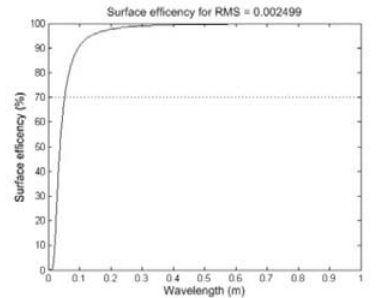
Figure 10: The surface efficiency against wavelength for the surface modelled in the last scanning epoch. The vertical axis is the surface efficiency as a percentage value against the horizontal axis denoting the wavelength in